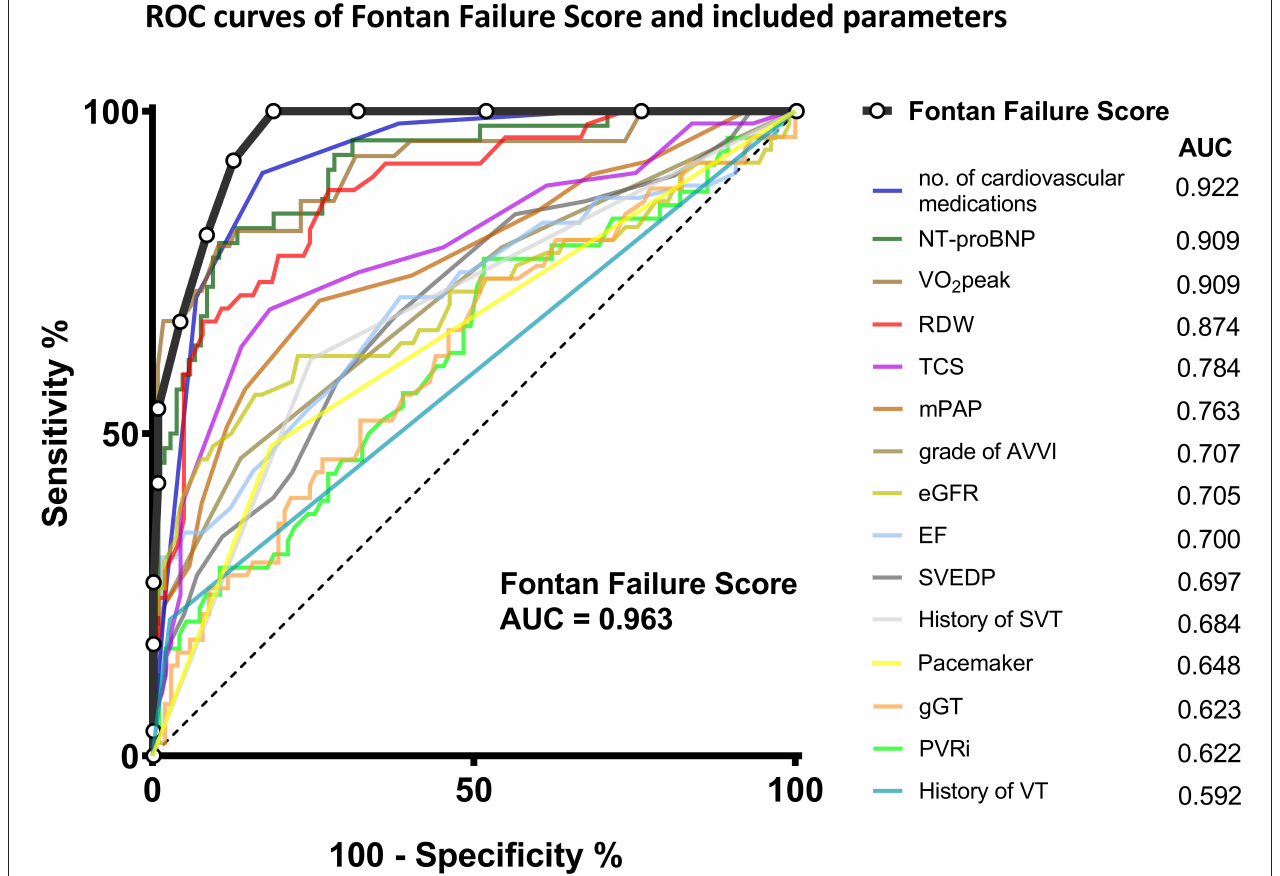
FIGURE 3 | Receiver operating characteristic curves of the Fontan Failure Score and its components to discriminate Fontan failure in our cohort of adult Fontan patients. Area under the curve for each parameter is indicated in the legend. AUC, area under the curve; AVVI, atrioventricular valve incompetence; EF, ejection fraction; eGFR, estimated glomerular filtration rate; gGT, γ -glutamyl transferase; mPAP, mean pulmonary artery/Fontan pressure; NT-proBNP, N-terminal pro-brain natriuretic peptide; PVRi, pulmonary vascular resistance index; RDW, red cell distribution width; ROC, Receiver operating characteristic; SVEDP, single ventricular end-diastolic pressure; SVT, supraventricular tachycardia; TCS, transcutaneous oxygen saturation at rest; VO2peak, peak oxygen uptake in cardiopulmonary exercise testing; VT, ventricular